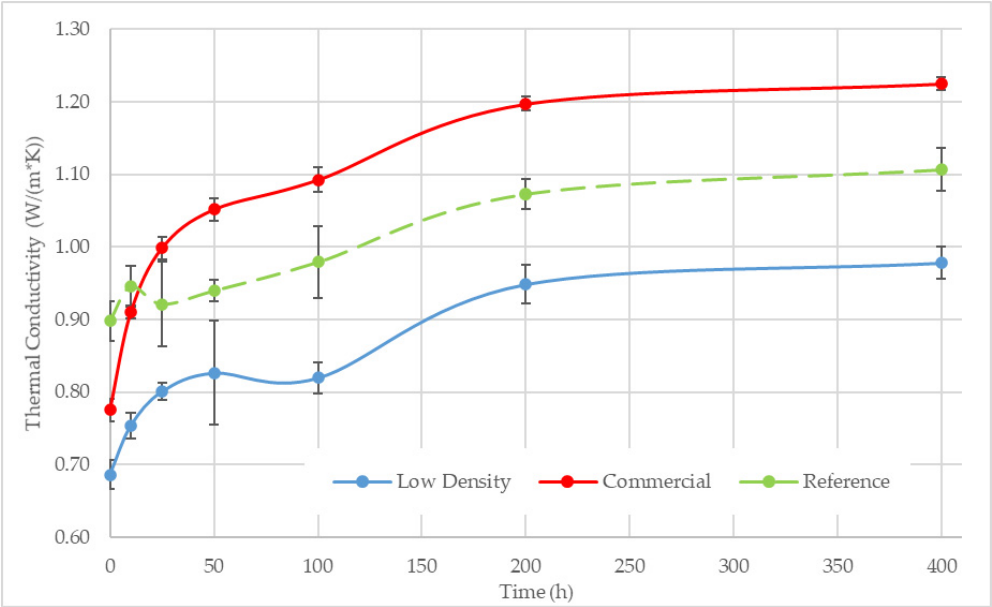
Figure 10. Thermal conductivity measured at 1200 °C for coatings isothermally heat treated at various time intervals.